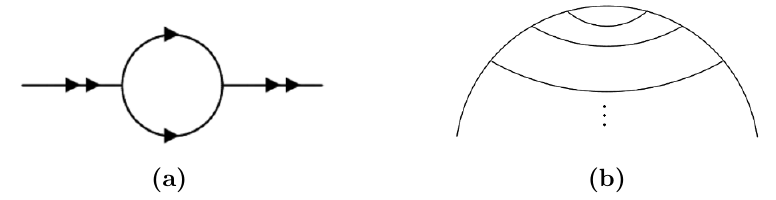
Figure 3. Con(cid:12)gurations allowed (a) and forbidden (b) by selection rule